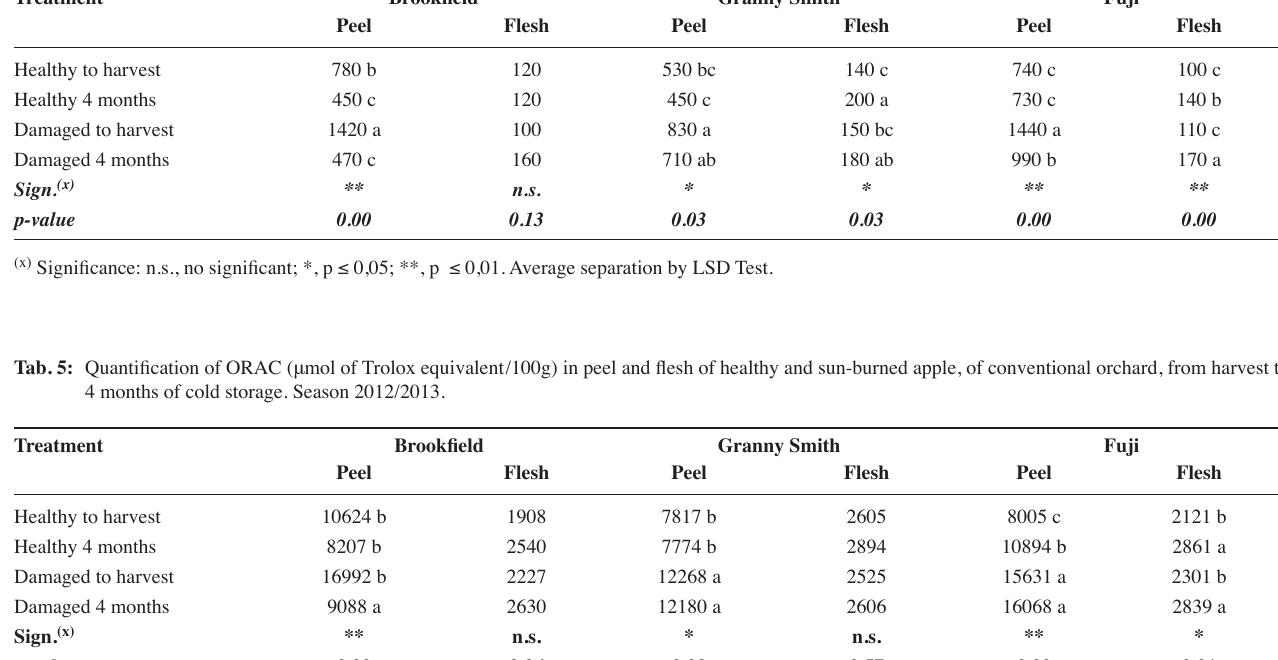
Tab. 4: Quantification of total phenolics compounds (mg Chlorogenic acid/100 g) in peel and flesh of healthy and sun-burned apple, of conventional orchards, from harvest to 4 months of cold storage, 2012/2013 season. Season 2012/2013. Treatment